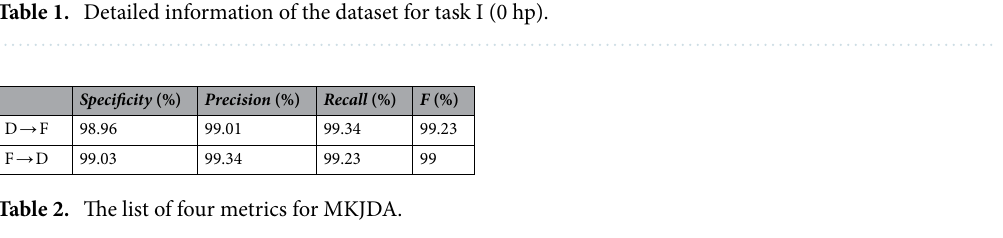
Table 1. Detailed information of the dataset for task I (0 hp).